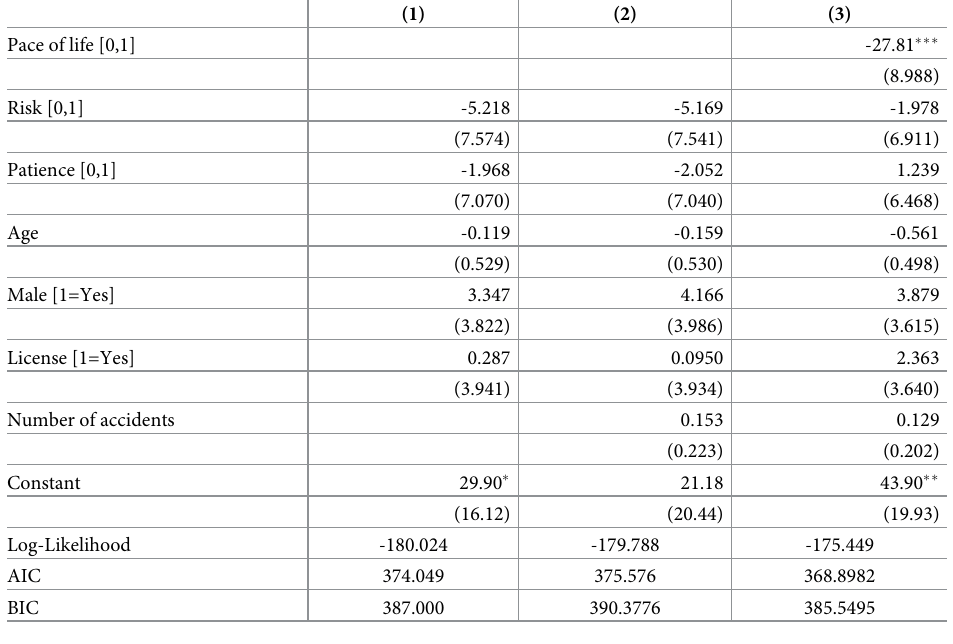
Table 7. Tobit regression on the number of strategy